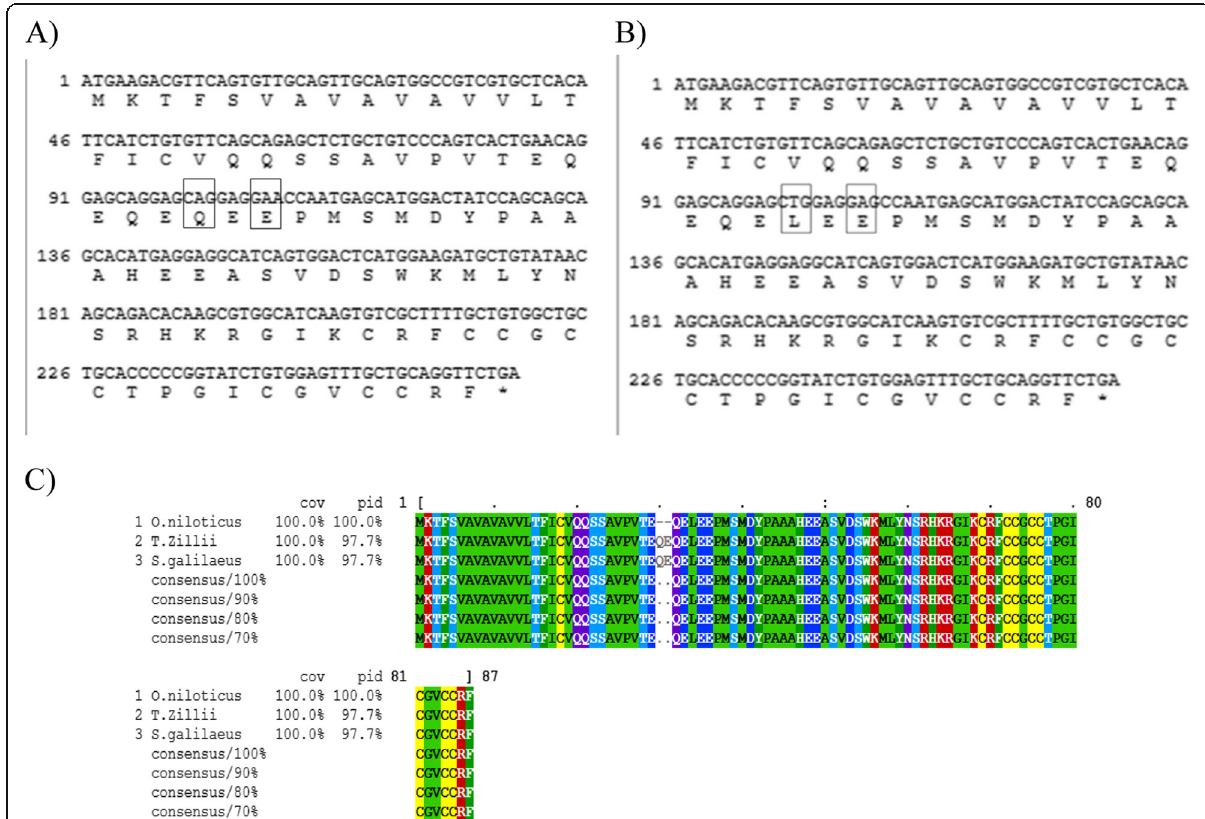
Fig. 3 a , b Nucleotide and amino acid sequences of different genotypes of S. galilaeus species. c Amino acids alignment of O. niloticus , T. zillii , and S. galilaeus species